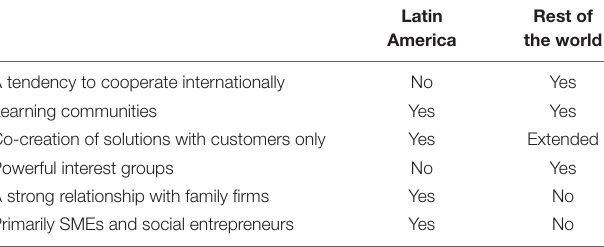
TABLE 1 | B Corps’ characteristics in Latin America vs. the rest of the